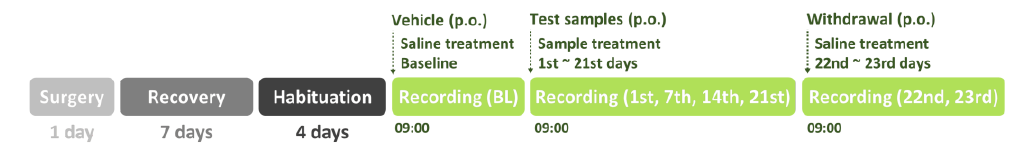
Figure 1. Experimental procedure involving chronic administration of GT for polysomnographic recordings. BL, baseline; p.o., per os administration.